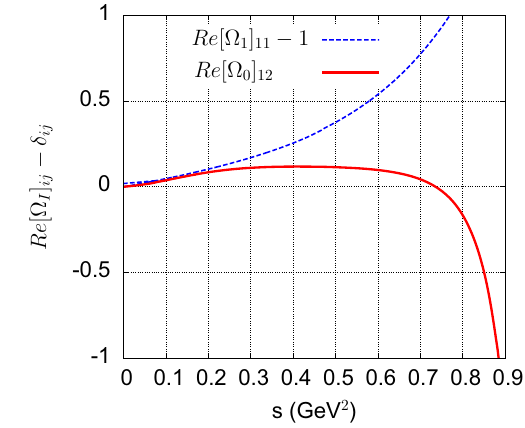
Fig. 6 Components of the Omnès matrices (cid:4) 0 and (cid:4) 1 , which play an important role (see text)